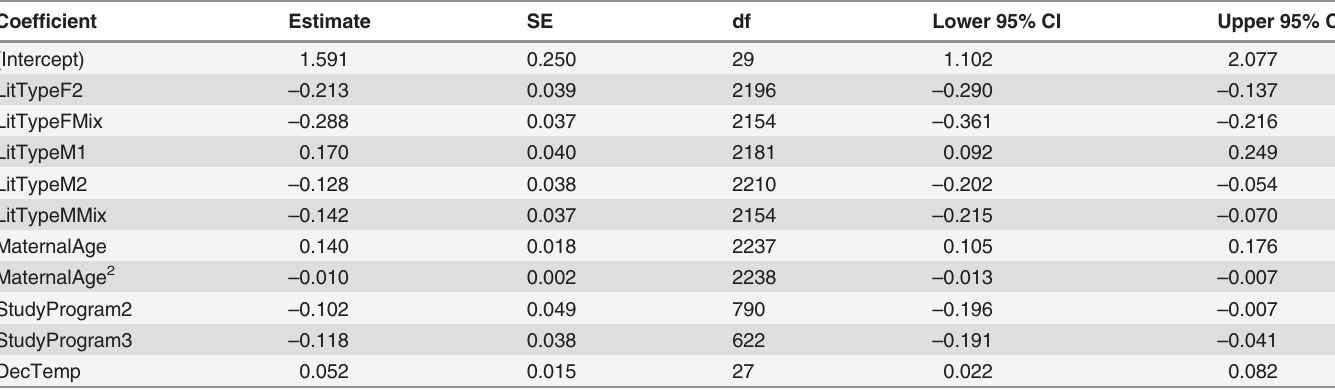
Table 6. Parameter estimates utilizing restricted maximum likelihood estimation for a linear mixed-effects model assessing the influence of bio- logical (litter type, maternal age, and study program) and environmental factors on birth mass of white-tailed deer at Kerr Wildlife Management Area, Kerr County, TX from 1977 –